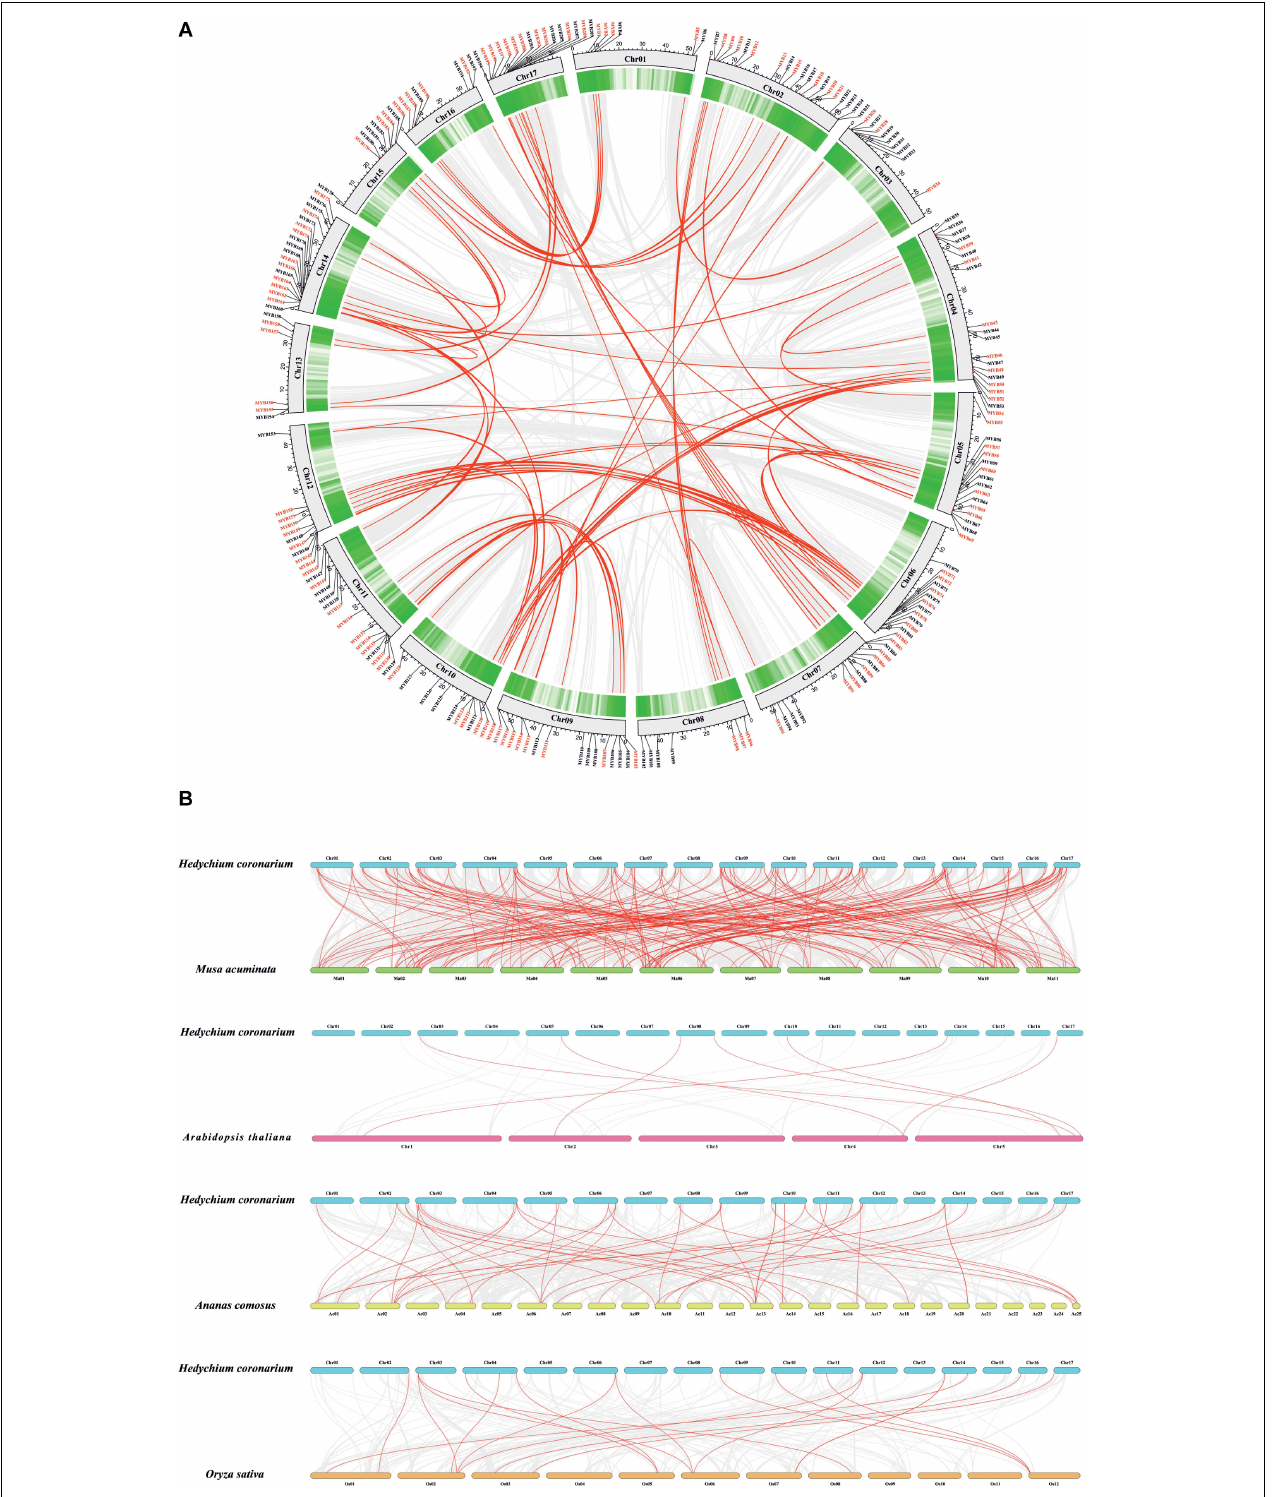
FIGURE 2 | Synteny and collinearity analysis of MYB gene family. (A) Circos plot of MYB genes in H. coronarium genome. Segmental duplication of MYB gene pairs is indicated by red color in H. coronarium . (B) Colinearity plot of HcMYB genes between Musa acuminata and three other representative plant species. Gray lines in the background showed collinear blocks within H. coronarium and other plant genomes, while red lines indicate syntenic MYB gene pairs.